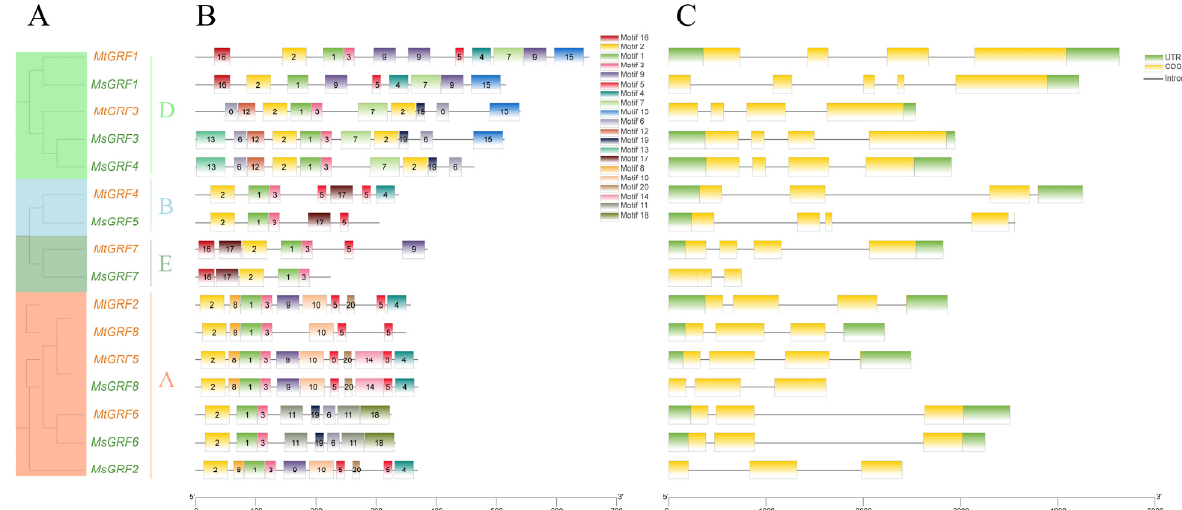
Figure 3. Phylogenetic relationships, motifs and gene structure of GRF genes from M. truncatula and M. sativa ( A – C ). The groups and its color in the phylogenetic tree were the same as in Figure 2. The motifs were indicated in different colored boxes with different numbers, and the sequence information for each motif was provided in Additional Figure 1. Green boxes indicate 5 ′ - and 3 ′ -untranslated regions; orange boxes indicate exons; black lines indicate introns.